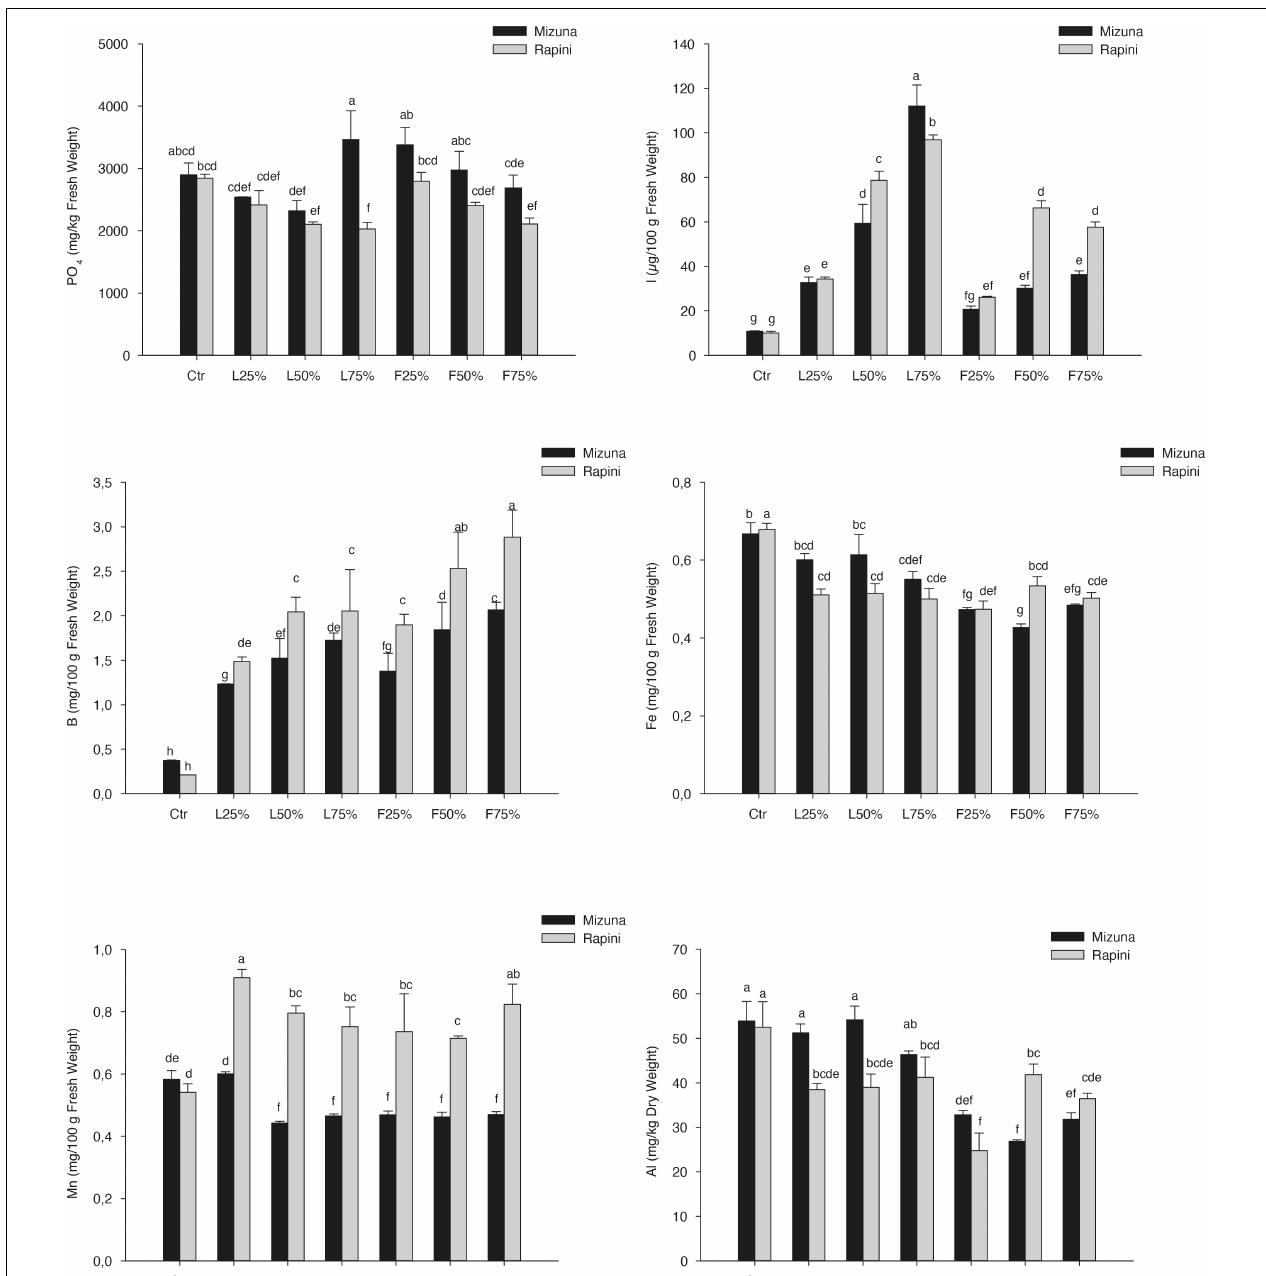
FIGURE 4 | Phosphates, Inorganic iodine, Boron, Iron, Manganese, and Aluminum content in the Brassica rapa L. Mizuna and Rapini microgreens as effected by Posidonia oceanica (L.) Delile (PO) leaves (L) and fibers (F) in the growing media. CTR (control 100% peat), L 25% (75% peat and 25% PO L), L 50% (50% peat and 50% PO L), L 75% (25% peat and 75% PO L), F 25% (75% peat and 25% PO F), F 50% (50% peat and 50% PO F) and F 75% (25% peat and 75% PO F). Data are expressed as mean ± standard error of treatment ( n = 3). Significance: *** P ≤ 0.001. Different letters indicate that mean values are significantly different according to the LSD test ( α =